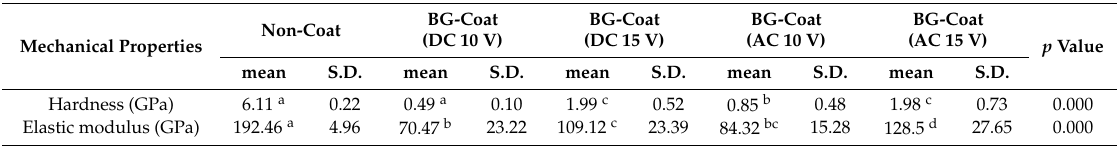
Figure 6. Time ‐ dependent changes in the pH of the solutions as an indication of acid neutralizing ability.